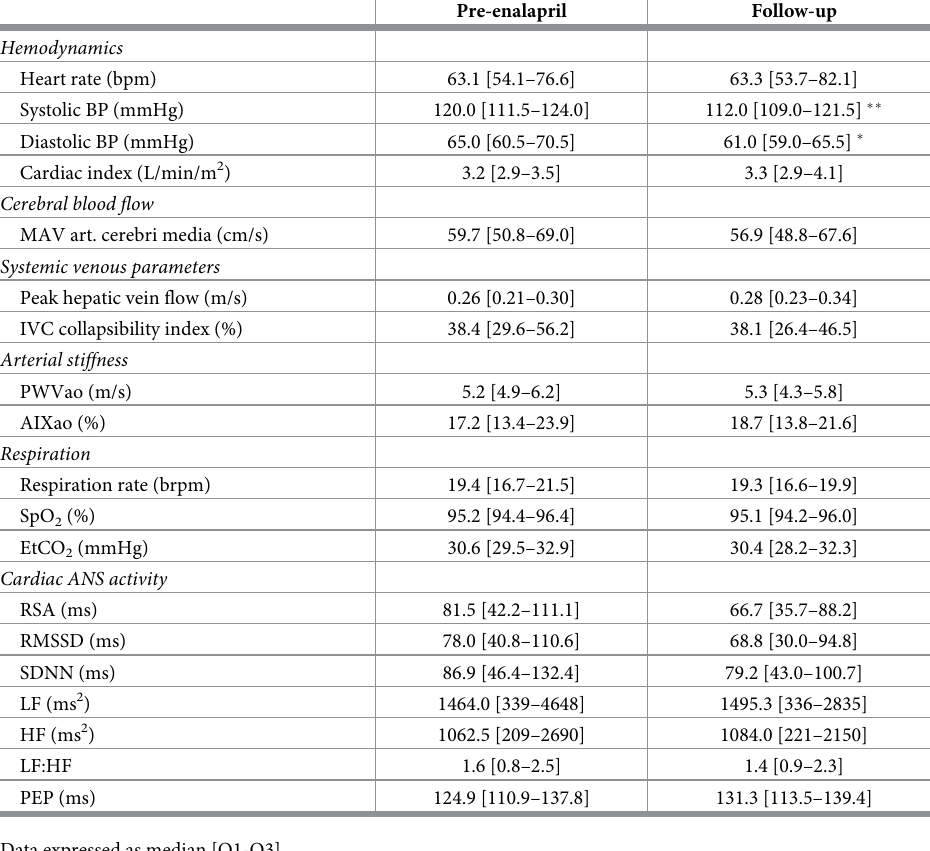
Table 4. Comparison of baseline measurements during supine rest between Fontan patients before enalapril treatment and at